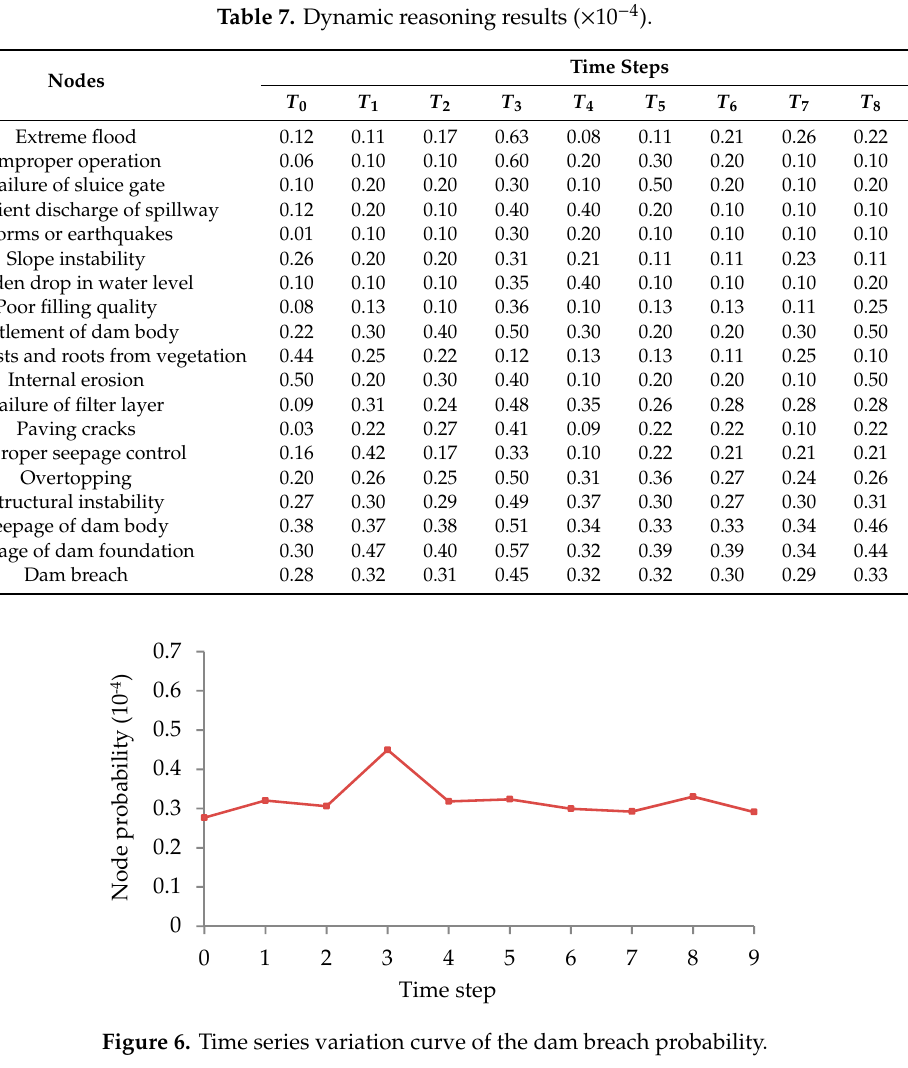
Table 7. Dynamic reasoning results (×10 − 4 ).